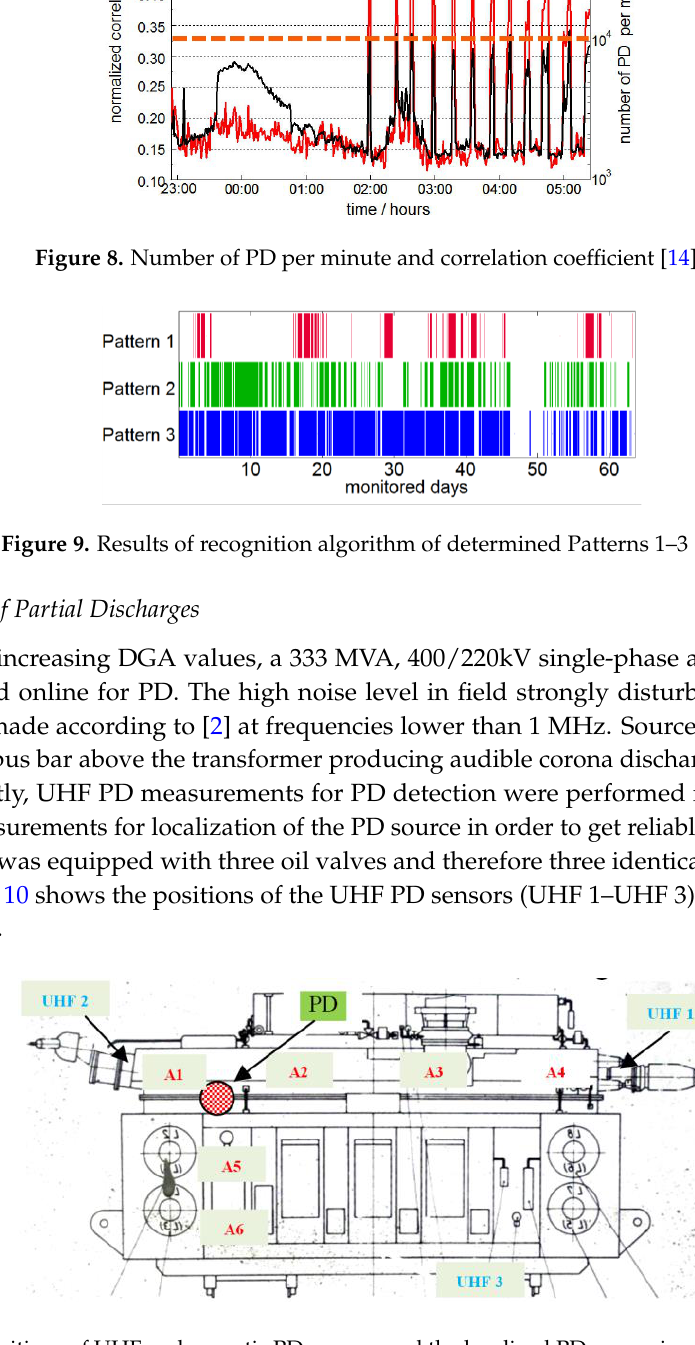
Figure 10. Positions of UHF and acoustic PD sensors and the localized PD source in a 333 MVA/400 kV single phase autotransformer [15].